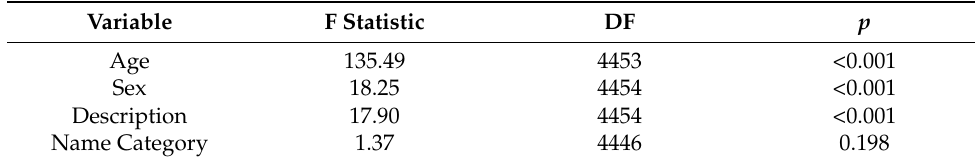
Table 3. Summary of the results from univariate analysis. All explanatory variables (age, sex and adoption description) were significant and carried into a multivariate analysis ( p < 0.001), except for the name category ( p = 0.198). Description = narrative voice (i.e., first person vs. third person). Refer to Table 4 for a numerical summary of the data by name category.